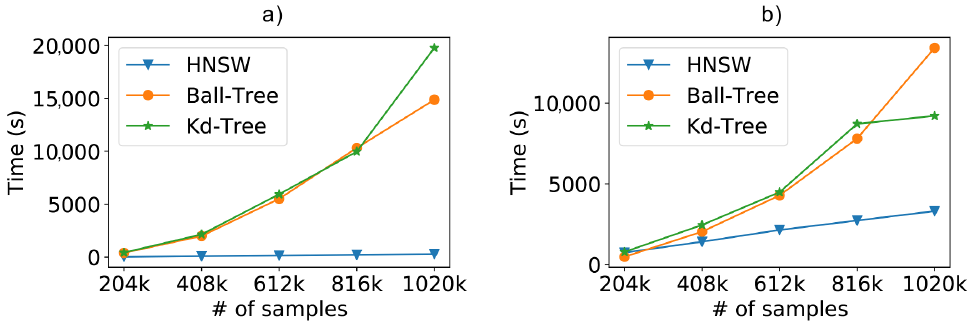
Figure 12. ( a ) Fitting time and ( b ) classification time evaluation results when using the real-world SmartCampus dataset and increasing the number of samples with K =